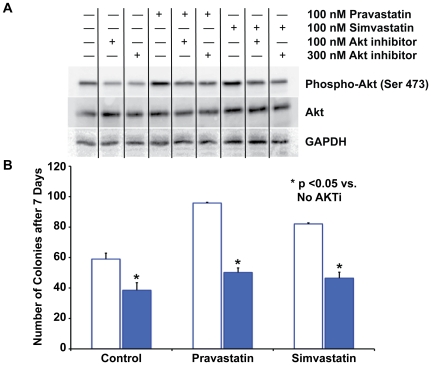
Clonogenic Growth of LOEPCs is Sensitive to AKT inhibition, while the Effect of Pravastatin and Simvastatin on LOEPC Clonogenic Growth is Not.
Panel A-Western blot analysis showing both pravastatin and simvastatin activate AKT phosphorylation, and AKT inhibitor IV blocks the phosphorylation of AKT in LOEPCs. Panel B-LOEPCs were grown under clonogenic conditions with or without an AKT inhibitor (100 nM), in the presence or absence of pravastatin or simvastatin (100 nM each) to determine if the effect of statins on LOEPC clonogenic growth as sensitive to AKT inhibition. n = 6 independent experiments. * p<0.05 vs. No Akt inhibitor IV.